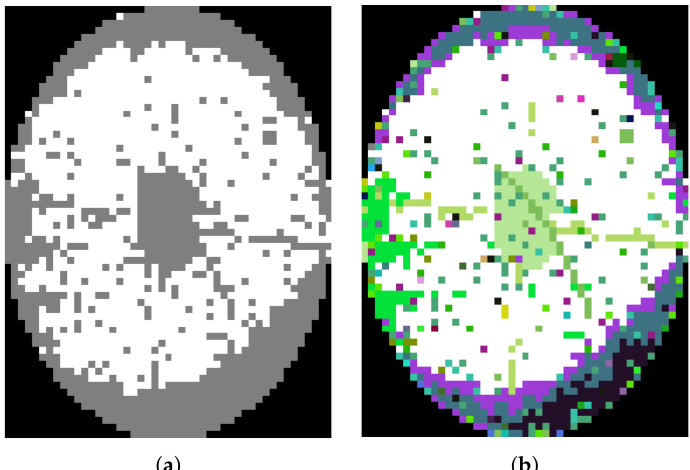
Figure 1. Examples of WBMs with different coloring schemes: ( a ) WBM in which bins that passed all EDS tests are white and all the other bins are gray, ( b ) WBM in which bins that passed all EDS tests are white and other bins are randomly assigned a color according to the bin